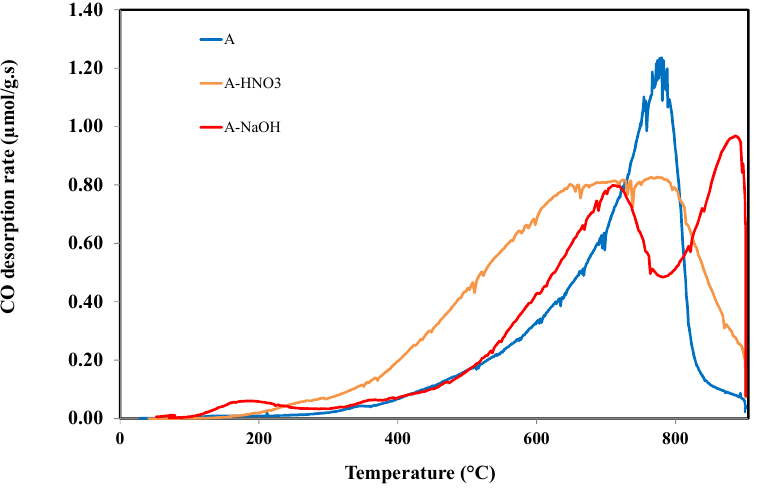
Figure 7. CO desorption profiles of sample A and samples of A treated by HNO 3 or NaOH.